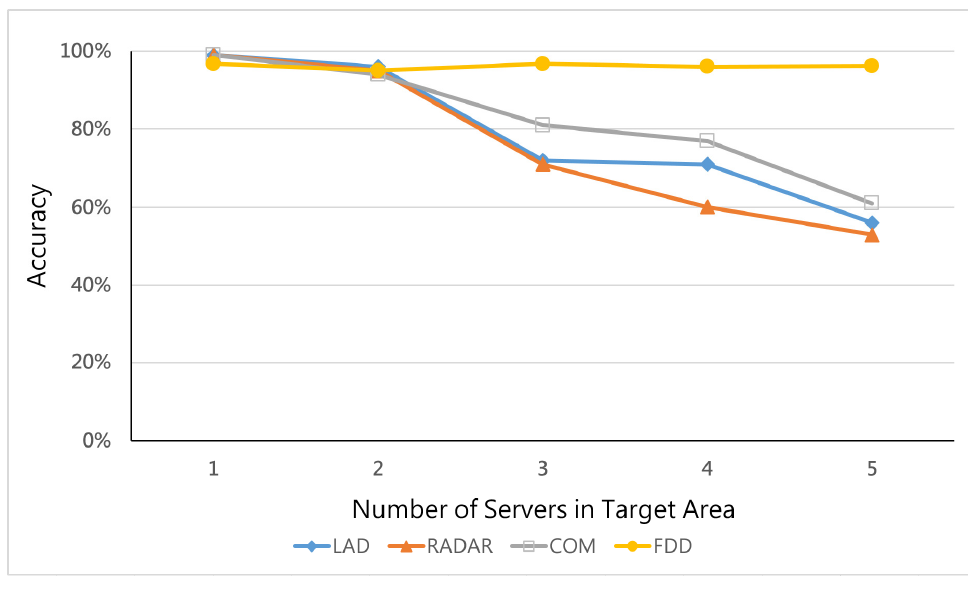
Figure 7. Accuracy vs. number of servers in the target area.